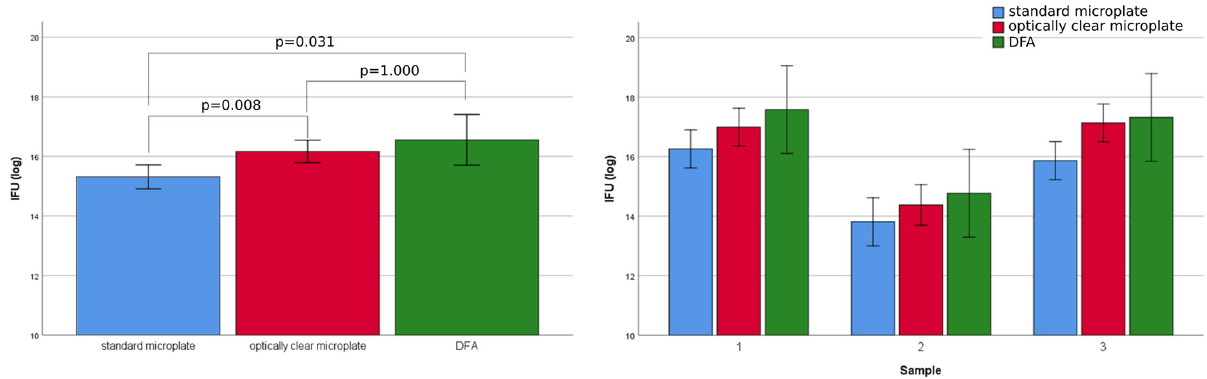
Fig 2. Quantification of C . trachomatis IFUs (IFU/mL) in samples with unknown chlamydial concentration via In-cell western and DFA assays. Bars represent mean values of log-transformed measures and error bars correspond to 95% confidence intervals (CI). The left panel shows the marginal means across the three samples and Bonferroni adjusted p-values for each of the three pairwise comparisons. The right panel shows the means (and 95% CI) for each sample (post-hoc comparisons are not reported since no evidence of Method � Sample interaction was found (p > 0.80)).